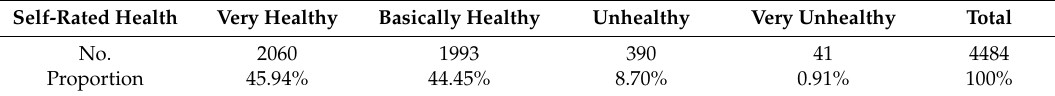
Table 1. Self-rated health value sampling distribution of the senior floating